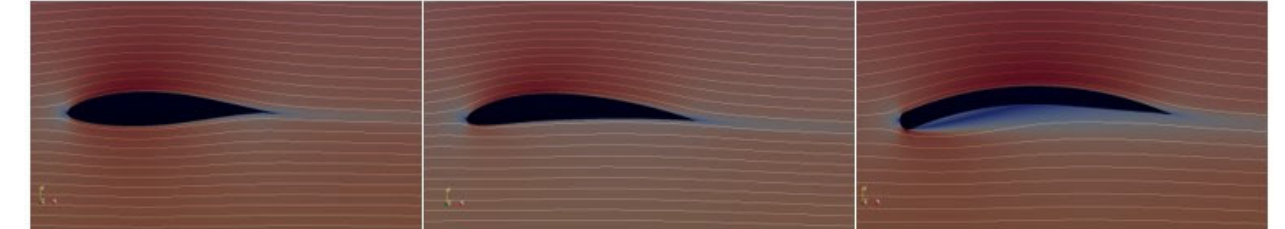
Figure 5. Illustrative representation of lift generation by 85 m/s entry velocity at zero angle of attack, as a result of different velocities at the top and bottom sides of the profiles for its different types: NACA 63415, NACA 6412 and Plate. Table 2. Values of forces acting on selected profiles with a zero angle of attack at the inflow of a stream at 85 m/s.